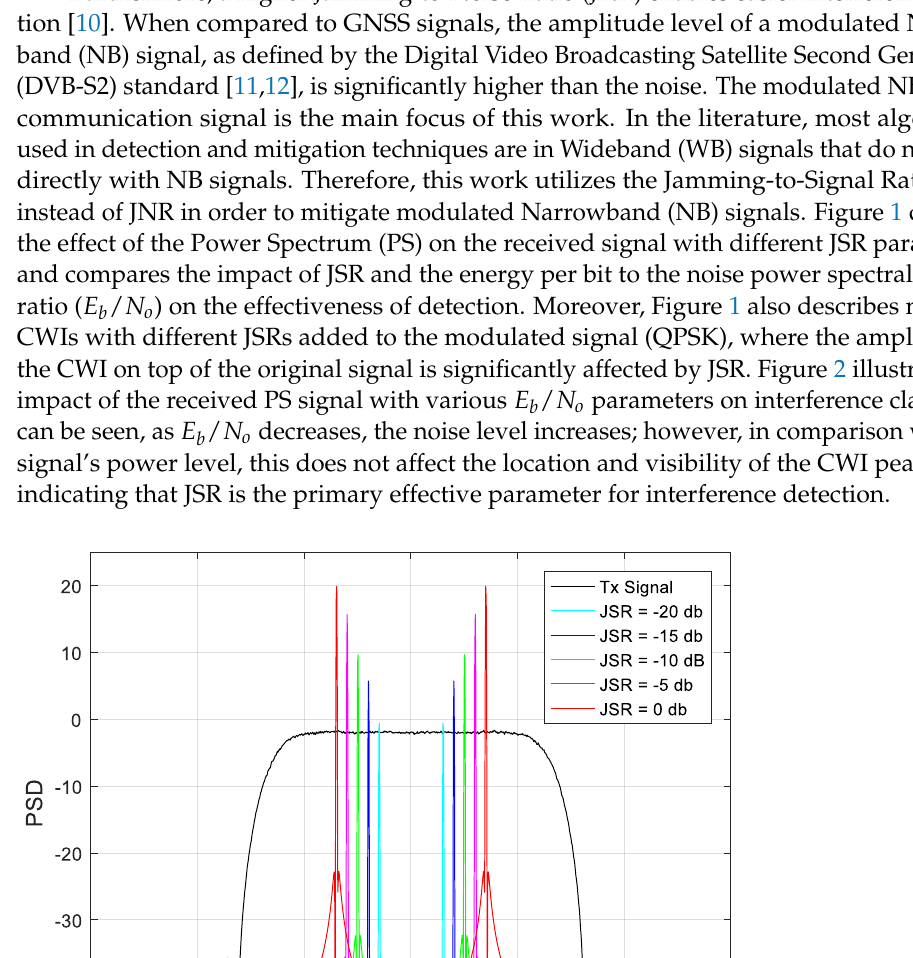
Figure 2. The received PS signal with various 𝑬 𝒃 𝑵 𝒐 ⁄ parameters 2. Related Works ANFs have been widely used with mitigation systems in different areas, such as bio- medical (e.g., cancel 60 Hz interference) [16,17], communications (e.g., reject NBI in the BPSK spread-spectrum communication system), and GNSS applications [18] and control (e.g., controlling the howling in speakerphone systems) [19]. In the literature, various mit- igation techniques already exist to reduce and remove the negative effects of RFIs, which can be classified into three groups: adaptive antenna-based techniques [20], Time – Fre- quency Filtering (TFF)-based methods [21,22], and adaptive-filtering-based techniques [15,23,24].